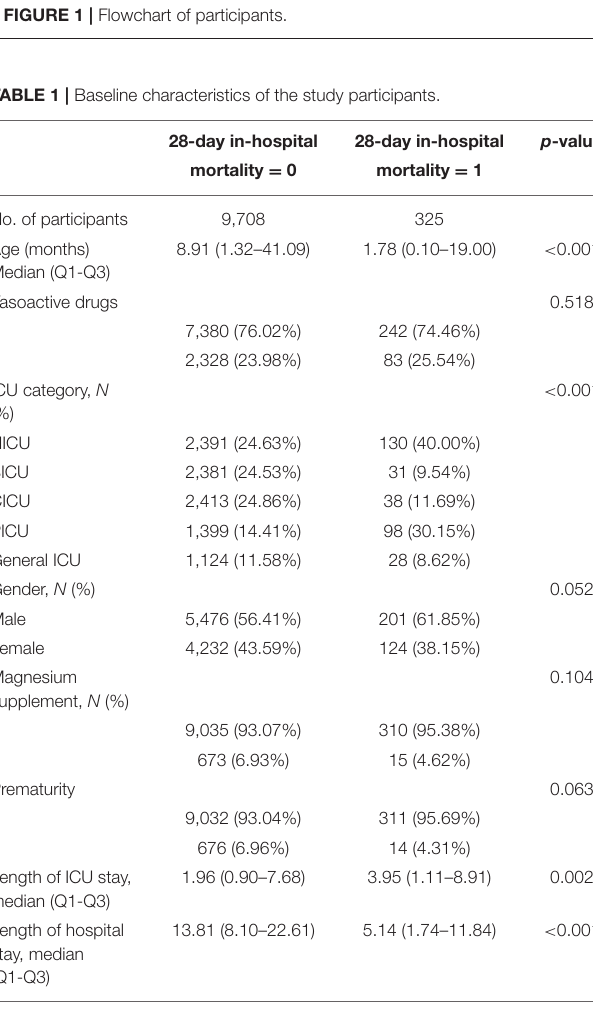
FIGURE 1 | Flowchart of participants.